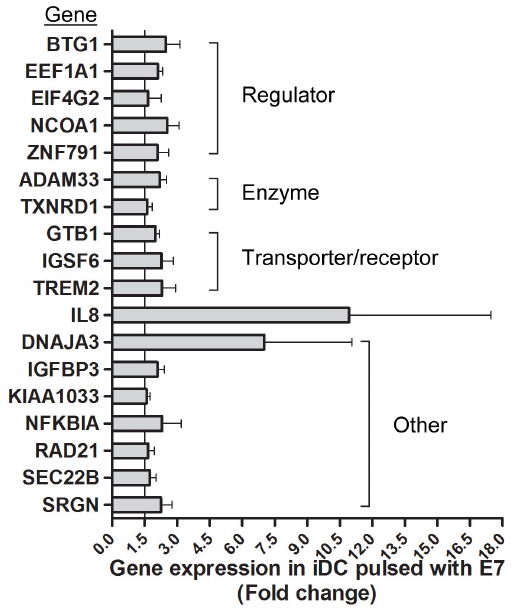
Figure 3. Significant genes of iDCs responding to E7 peptide pulsing. Gene expressions were compared between non-pulsed and pulsed piDCs from donor D1–D4 using two-class paired SAM. Statistical criteria was set as FDR , 0.05 and fold change $ 1.5.